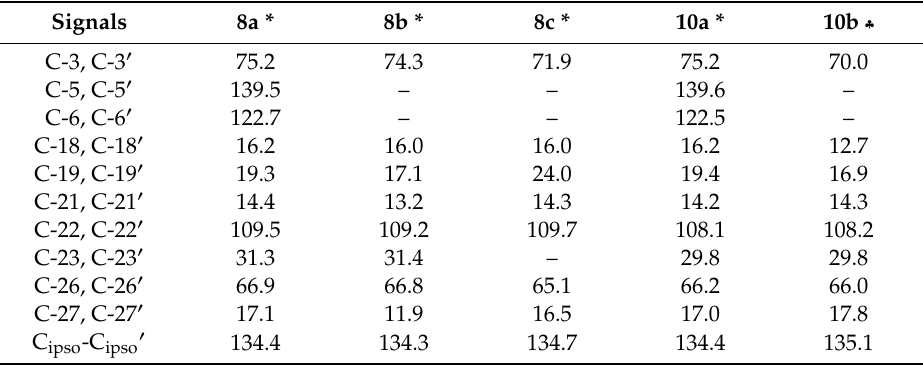
Table 4. Selected 13 C-NMR signals of the 8a–c and 10a–b in ppm.